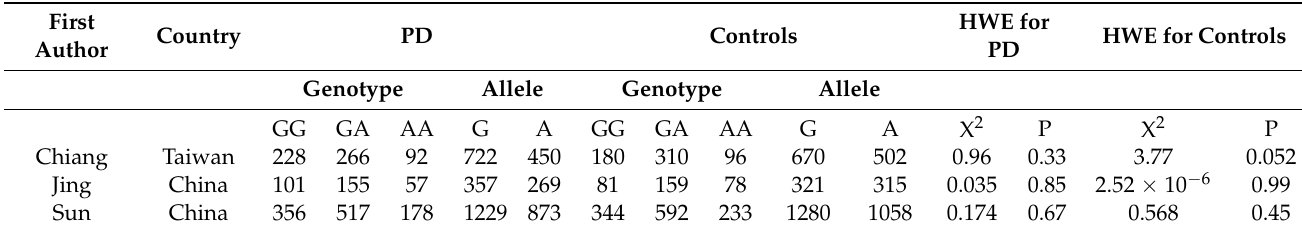
Table 1. Genotype distribution of the three studies included in the meta-analysis.